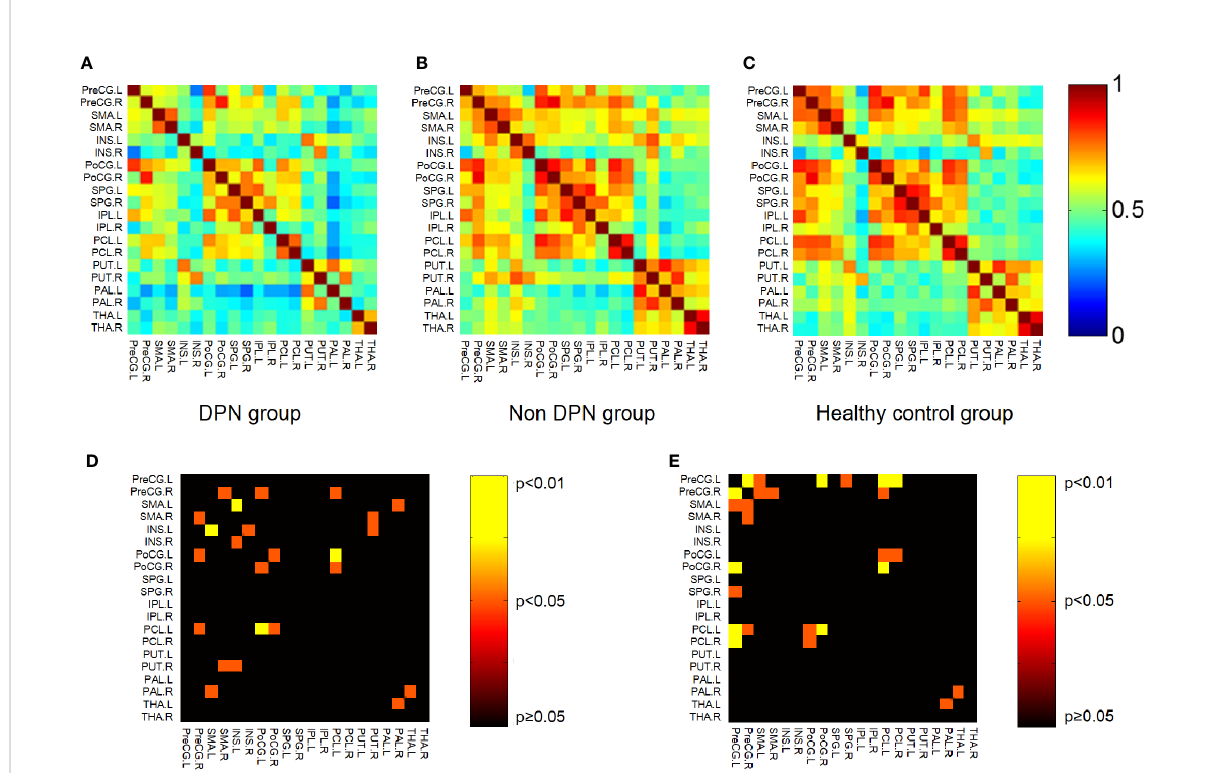
FIGURE 4 Connection matrix and weakened connections of brain region related to sensorimotor processing. (A) Brain connection matrix of the DPN group. (B) Brain connection matrix of the non-DPN group. (C) Weakened connections in regions related to sensorimotor processing in the DPN group compared with the non-DPN group. Warm color (non-DPN>DPN). (D) Weakened connections in regions related to sensorimotor processing in the DPN group compared with the non-DPN group. Warm color (non DPN>DPN). (E) Weakened connections in regions related to sensorimotor processing in the DPN group compared with the HC group. (PreCG, precentral gyrus; SMA, supplementary motor area; INS, insula; PoCG, postcentral gyrus; SPG, superior parietal gyrus; IPL, inferior parietal lobule; PCL, paracentral lobule; PUT, putamen; PAL, globus pallidum; THA,